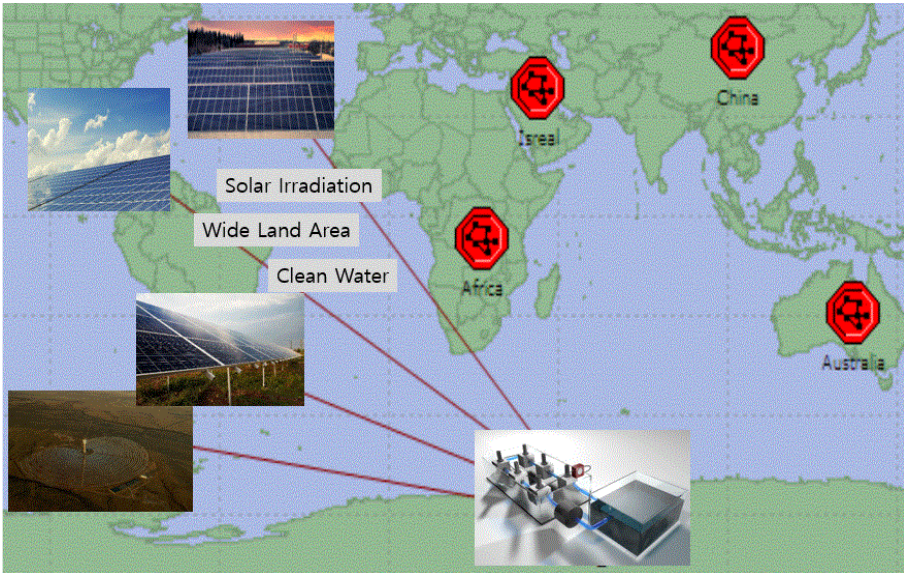
Figure 4. Graphical abstract of solar power and aquaculture in the desert.